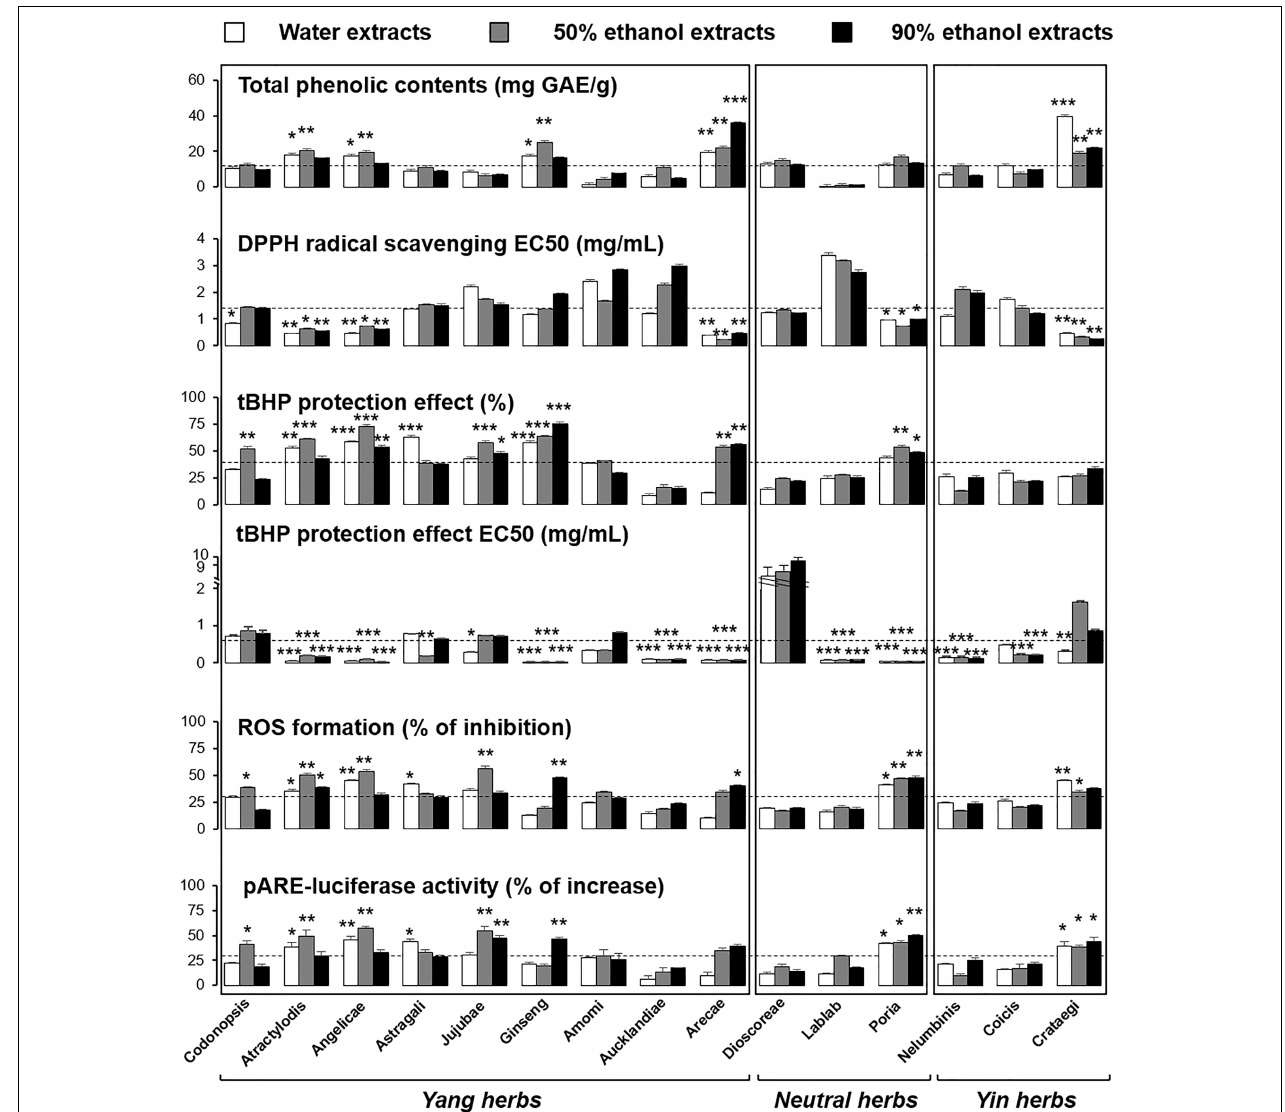
FIGURE 10 | The correlation between anti-oxidative profiles of the spleen-meridian herbs with the “Yin-Yang” classification criterion. Values are expressed as Mean ± SD, where n = 4, each with triplicate samples. Statistical comparison was made with mean value. The mean value of total phenolic compounds was 12.87 mg GAE/g; mean value of DPPH radical scavenging EC50 was 1.38 mg/mL; mean value of tBHP protection effect was 37.9%; mean value of tBHP protection effect at IC50 was 0.65 mg/mL; mean value of inhibition effects to ROS formation was 30.5%; mean value of pARE-luciferase activity increase was 29.6%. ∗ p < 0.05; ∗∗ p < 0.01; ∗∗∗ p <